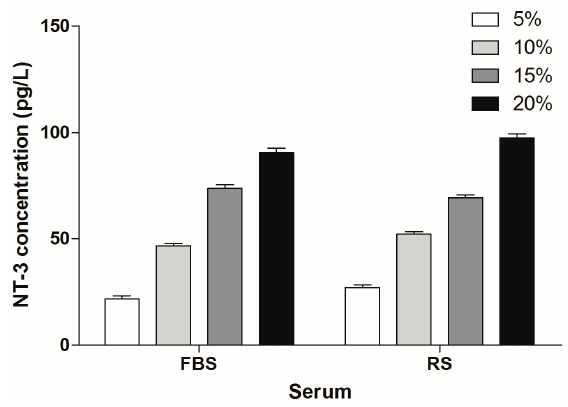
Figure 9. The concentration of NT-3 in the culture medium containing different concentrations of serum was detected by ELISA. There are eight kinds of